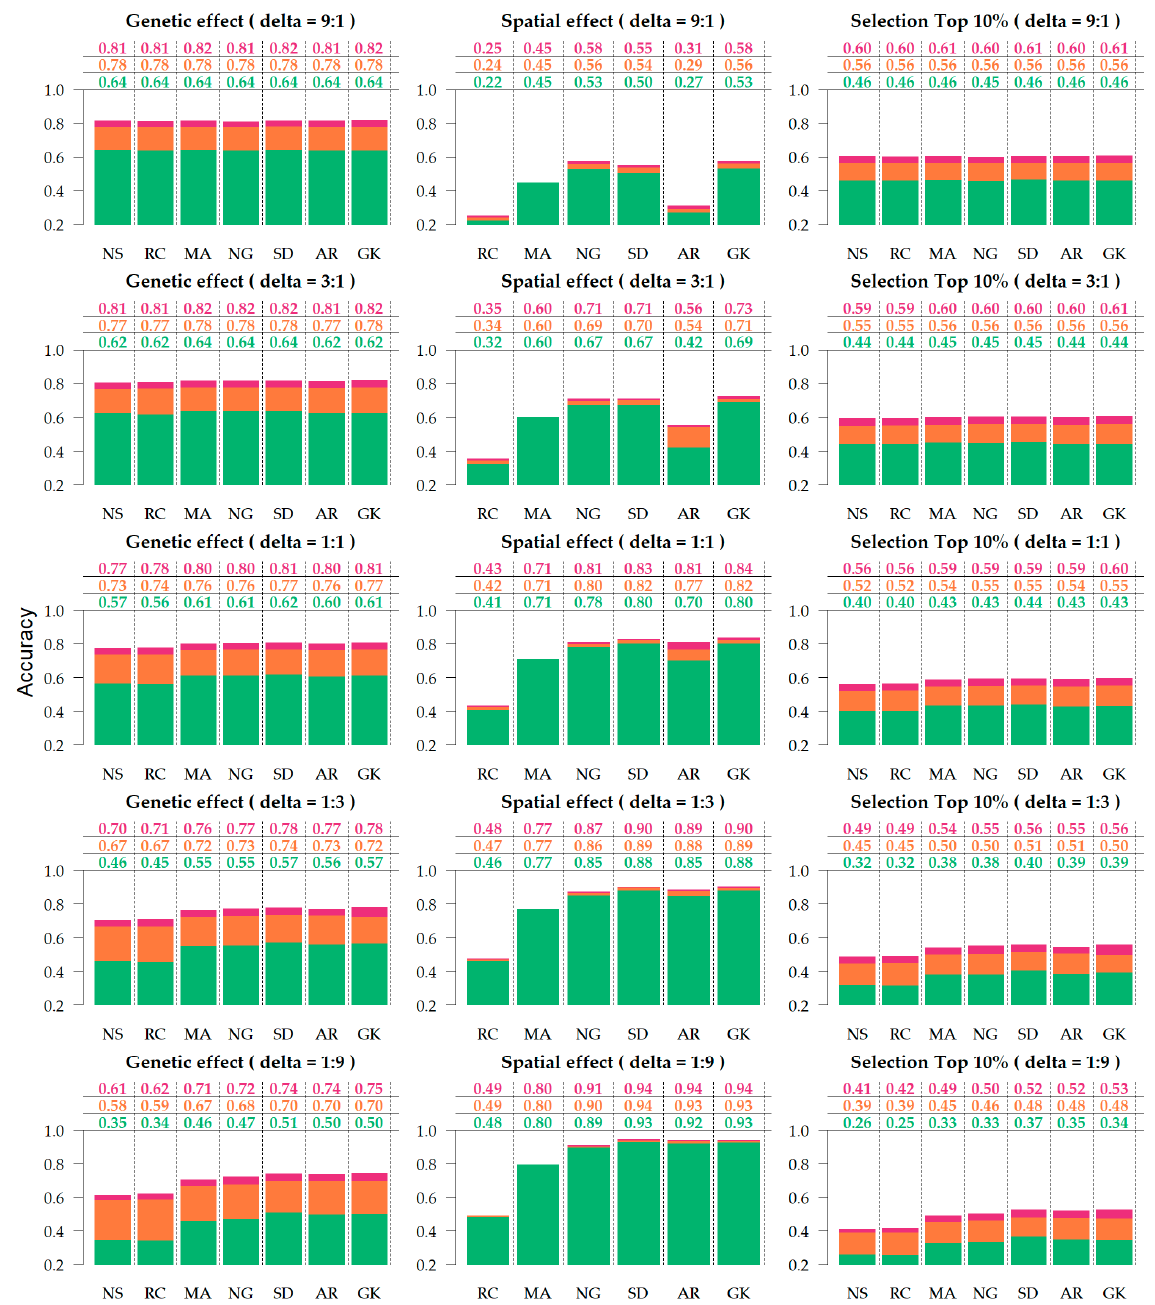
Figure 3. Accuracy of genetic effect, spatial effect, and selection, under varying residual-to-spatial variance ratios ( δ = σ 2 e : σ 2 s ). Colors correspond to the genetic relationship: Identity (green), pedigree (orange), genomics (red). Spatial adjustment methods on x-axis: no spatial adjustment (NS), row-column (RC), moving average covariate (MA), autoregressive AR1 × AR1 (AR), SPDE (SD), nearest neighbor graph (NG), and Gaussian kernel (GK).